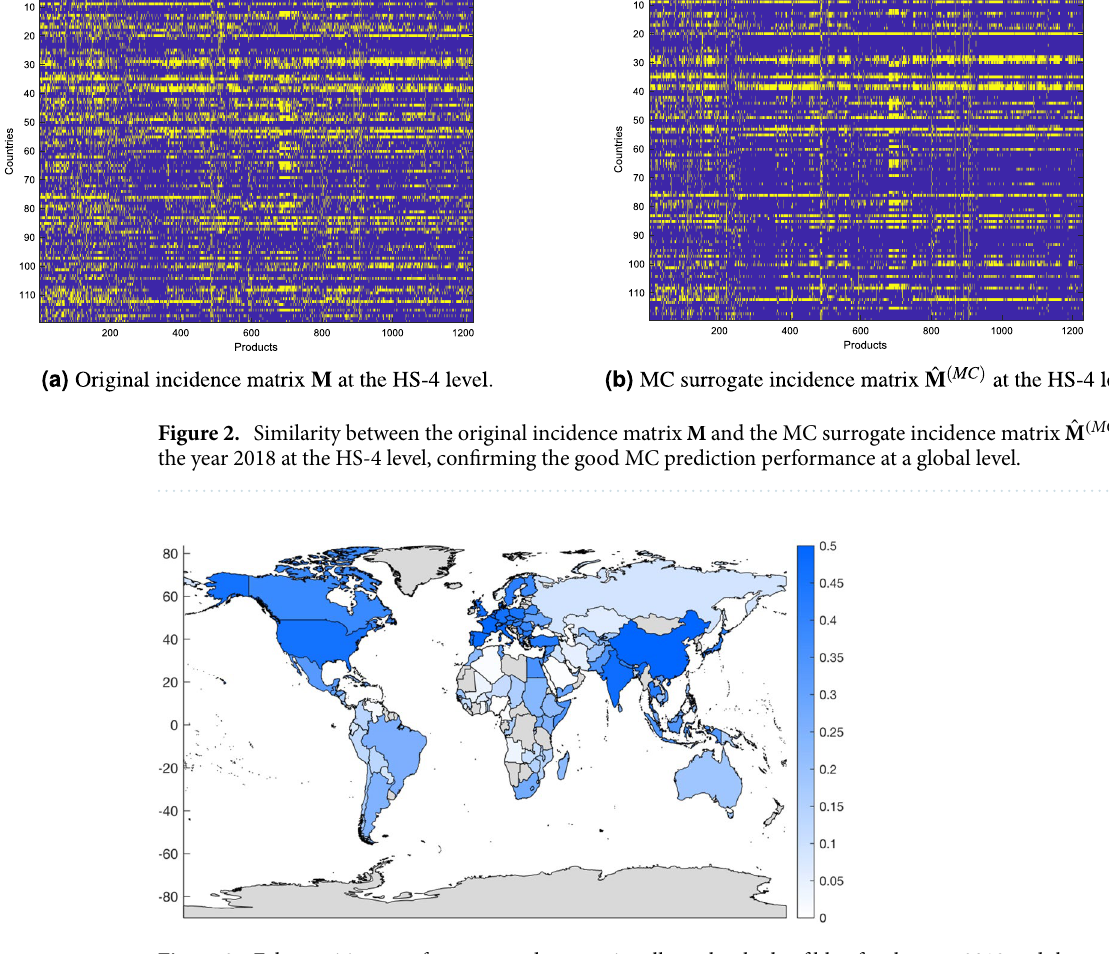
Figure 3. False positive rate fpr c , reported proportionally to the shade of blue for the year 2018 and the product aggregation level HS-4. The map was generated using the MATLAB 2012b package borders , available for free (upon registration) at the following hyperlink: https:// it. mathw orks. com/ matla bcent ral/ filee xchan ge/ 50390- borde